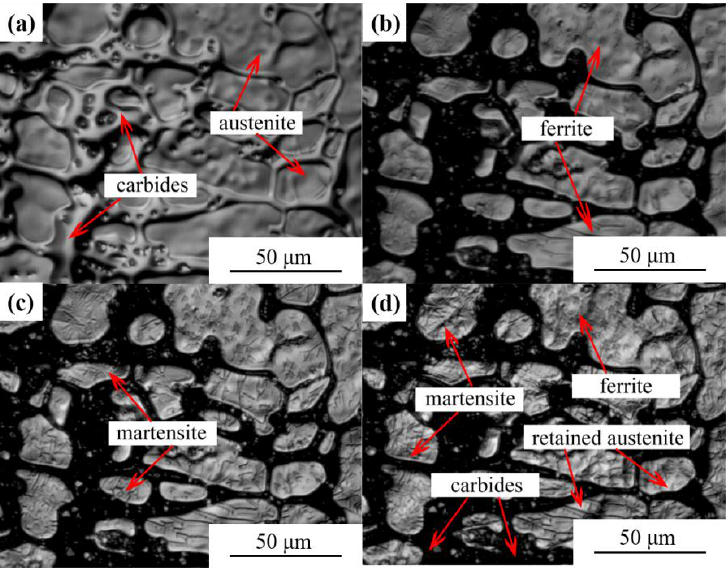
Figure 11. In-situ observation of phase transformation during austenitizing process of AISI M42 HSS with the cooling rate of 20 K/s: ( a ) 1473 K (×1000); ( b ) 1323 K (×1000); ( c ) 421 K (×1000); ( d ) room temperature (×1000).